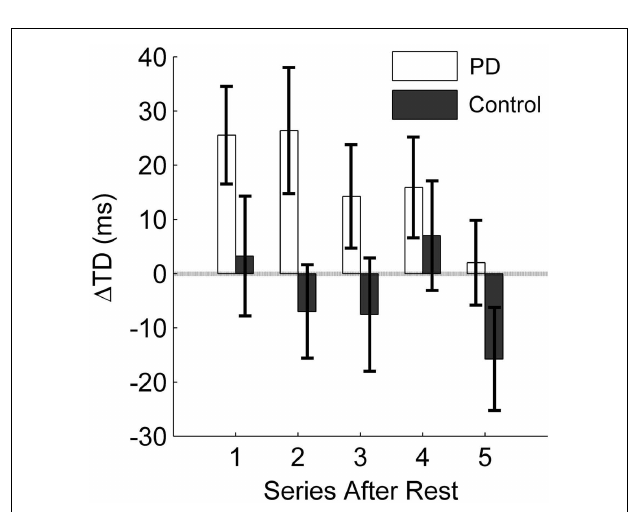
FIGURE 7 | Influence of initiation intervention on the temporary factor release timing. The difference between a change in timing from pre-rest to post-rest with intervention and without intervention is displayed.The average difference in milliseconds for the first five series after rest (10 trials each) is displayed for the PD patients and the control group. Positive values indicate a positive effect of the intervention on timing; negative values result when the intervention leads to poorer timing as compared to no intervention. Error bars denote the standard error of the